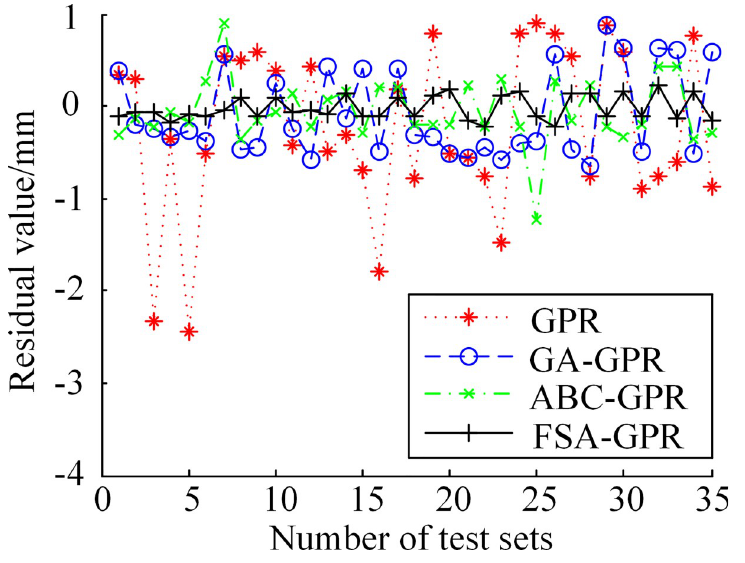
Fig 4. Residual comparisons of the four